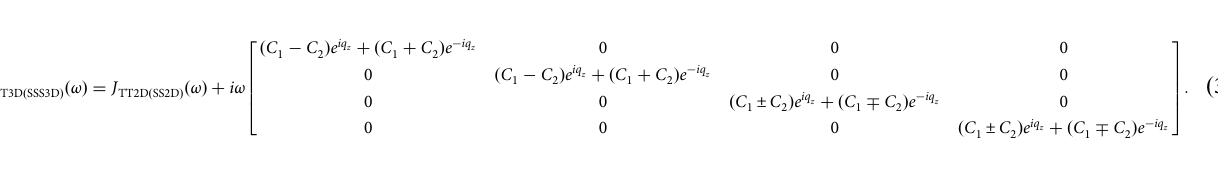
J STT3D ð SSS3D Þ ð ω Þ ¼ J TT2D ð SS2D Þ ð ω Þ þ i